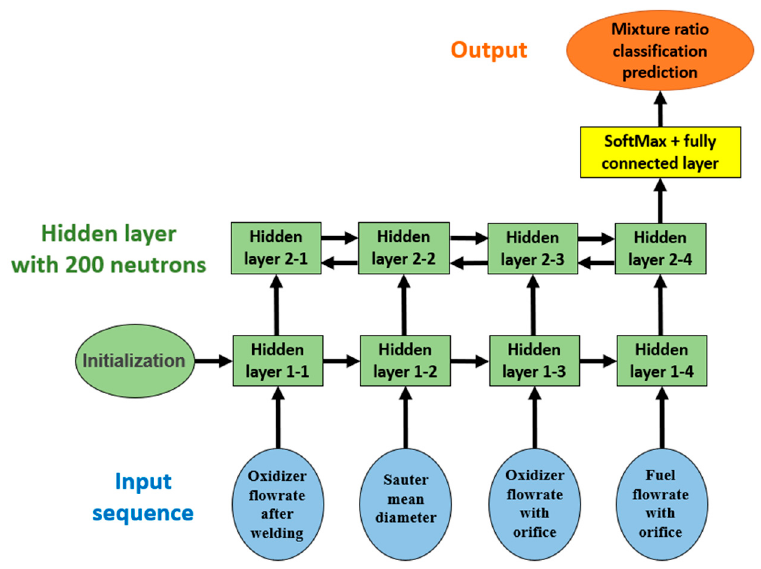
Figure 6. The prediction network structure based on RNN with high-weight input sequence.